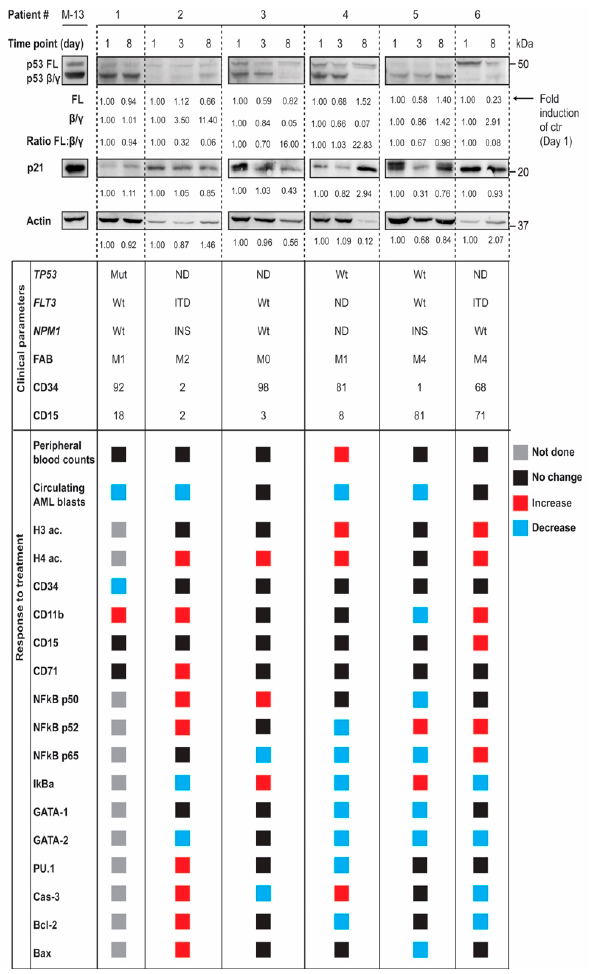
Figure 4. In vivo modulation of p53 protein isoforms during differentiation therapy in AML. Samples were collected from AML patients undergoing combination therapy of valproic acid (VPA), all- trans retinoic acid (ATRA) and theophylline before treatment (day 1), after treatment with ATRA (day 3) and after treatment with the triple combination (day 8). Samples were analyzed by 1D gel electrophoresis and Western blotting with antibodies against p53 (DO-12), p21 and actin. Regions in Western blots were quantified and ratios of p53 FL: p53 β / γ were calculated and given as fold induction of control (day 1). Clinical parameters including TP53, FLT3 and NPM1 status, FAB classification, CD34, CD15 and response to treatment, including peripheral blood counts and circulating AML blasts are shown below. Histone acetylation, proliferation, differentiation and apoptosis markers are analyzed by flow cytometry. Results are based on median fluorescence intensity (MFI), except from CD markers and cell cycle markers, where results are based on % positive cells. Response to treatment is marked grey for not done, black for no change, red for increase and blue for decrease. Abbreviations: ac, acetylation; Bax, Bcl-2-like protein 4; Bcl-2, B-cell lymphoma; CD, cluster of differentiation; FAB, French–American–British; FL, full-length; FLT3, FMS-like tyrosine kinase 3; GATA, globin transcription factor; H3, Histone H3; H4, Histone H4; IkBa, nuclear factor of kappa light polypeptide gene enhancer in B-cells inhibitor, alpha; ITD, Internal tandem duplication; MDS, myelodysplastic syndrome; ND, not done; NFkB, nuclear factor kappa-light-chain-enhancer of activated B cells; Wt, Wild